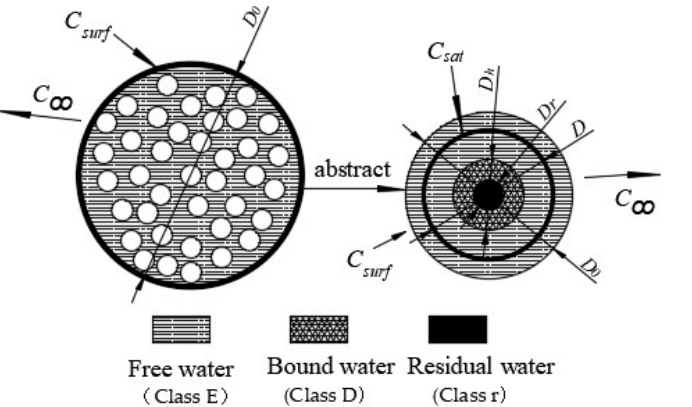
Figure 12. Schematic diagram of Baijiu yeast granule drying model. C ∞ . Water vapor concentration in the air far from the pellet, C surf . Water vapor concentration in the air in contact with the external pellet surface, C sat . Saturation concentration of water in pellet, D . Real time diameter of yeast particles, D h . Diameter of bound water, D r . Diameter of the residual water, D 0 . Yeast particle initial